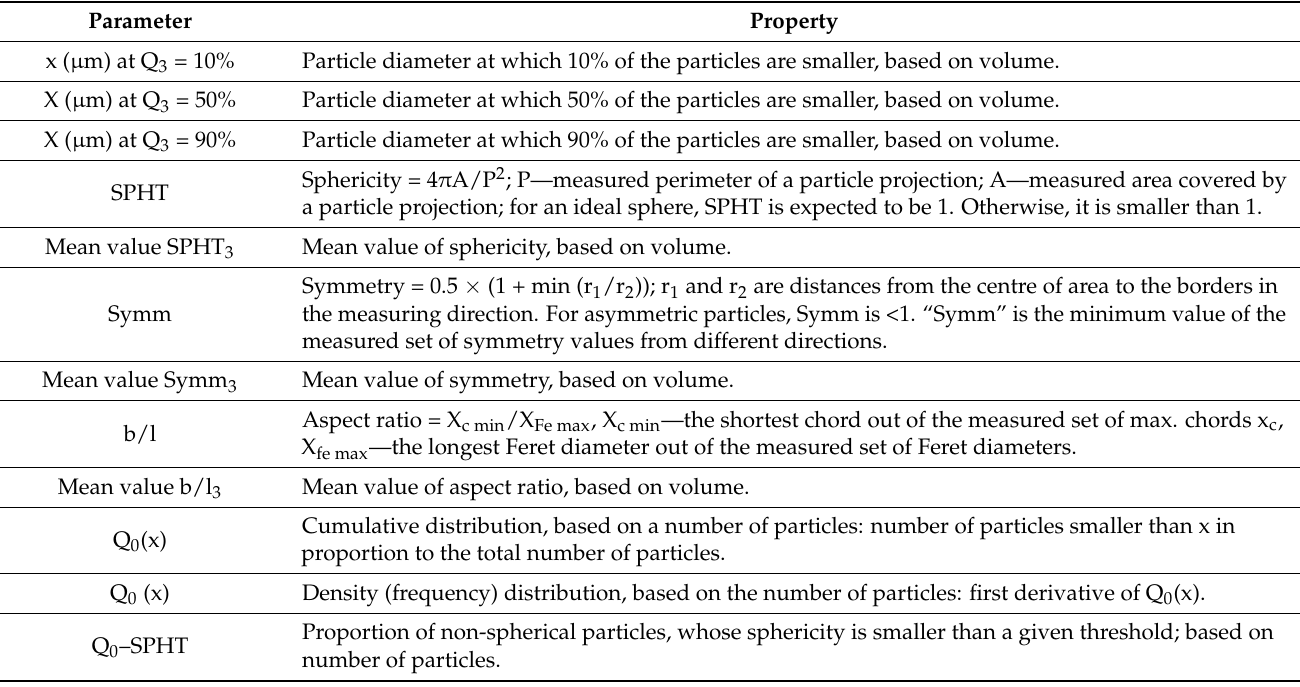
Table 2. Measured properties of the cementitious particles determined by dynamic digital image processing. Parameter